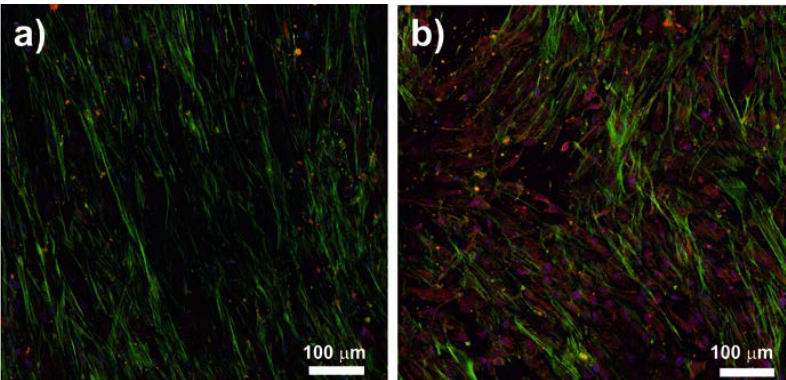
Figure 6. Confocal fluorescence microscopy images of cells after 14 days of culture (with differentiation medium) in: ( a ) glass; ( b ) high density of microparticles (HD-M) film. The picture shows bone-specific osteocalcin (red), the cells actin cytoskeleton (green) and the nucleus (blue). The scale bar (100 μm) is valid for all images.